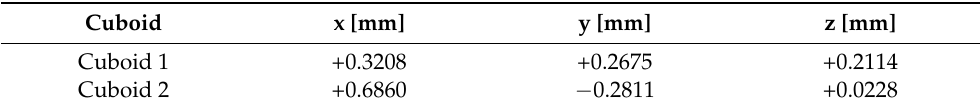
Table 3. Deviations of the cuboid measurements between touch probe and laser object detection with laser scanner.